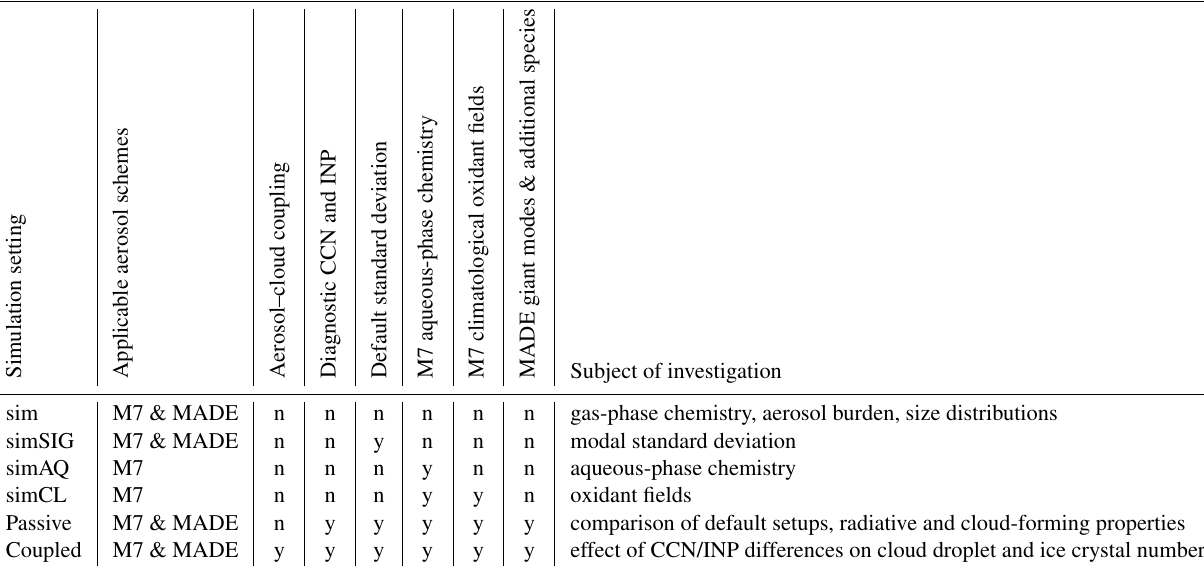
Table 4. List of simulations. A “y” shows that a model feature is active if applicable (aqueous-phase chemistry and climatological oxidant fields are only active for M7 simulations and giant modes only apply to MADE simulations). An “n” indicates it is not active. See main text for